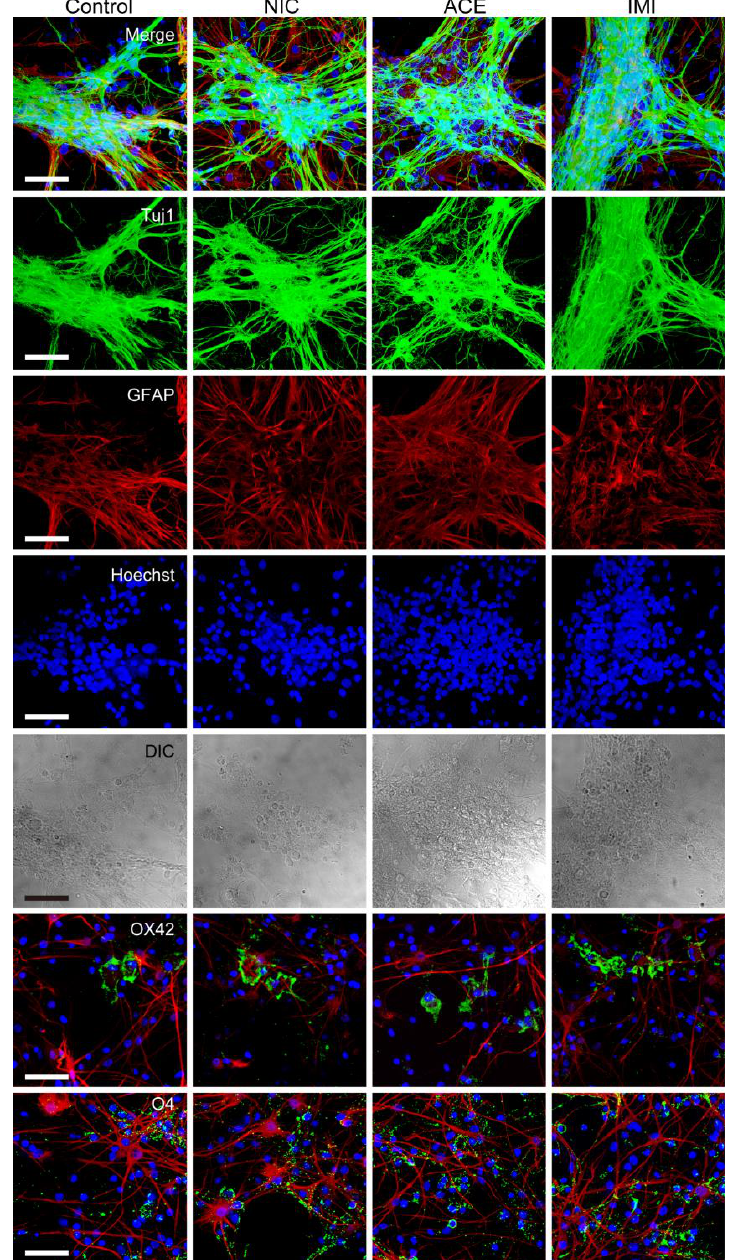
Figure 1. Morphology of cells in cerebellar cultures exposed to nicotine (NIC), acetamiprid (ACE), and imidacloprid (IMI) for 14 days (16DIV). Horizontal rows from top to bottom show merged images (Tuj1, glial fibrillary acidic protein (GFAP), and Hoechst); Tuj1-positive neurons; GFAP-positive astrocytes; Hoechst-positive nuclei; differential interference contrast (DIC) images; OX42-positive microglia (green); and O4-positive oligodendrocytes (green). From the first to the fifth row, the same sample is shown. In the OX42 and O4 rows, red represents GFAP and blue is Hoechst stain. The photos of microglia and oligodendrocytes were obtained from areas of sparse cell density, because their morphology was easy to identify. Bars = 50 μm. No notable morphological differences were observed between the groups.